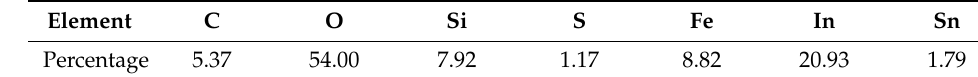
Figure 2. EDX result of the precursor film deposited at − 1.0 V. Table 1. Atomic percentage of the precursor film deposited at − 1.0 V.